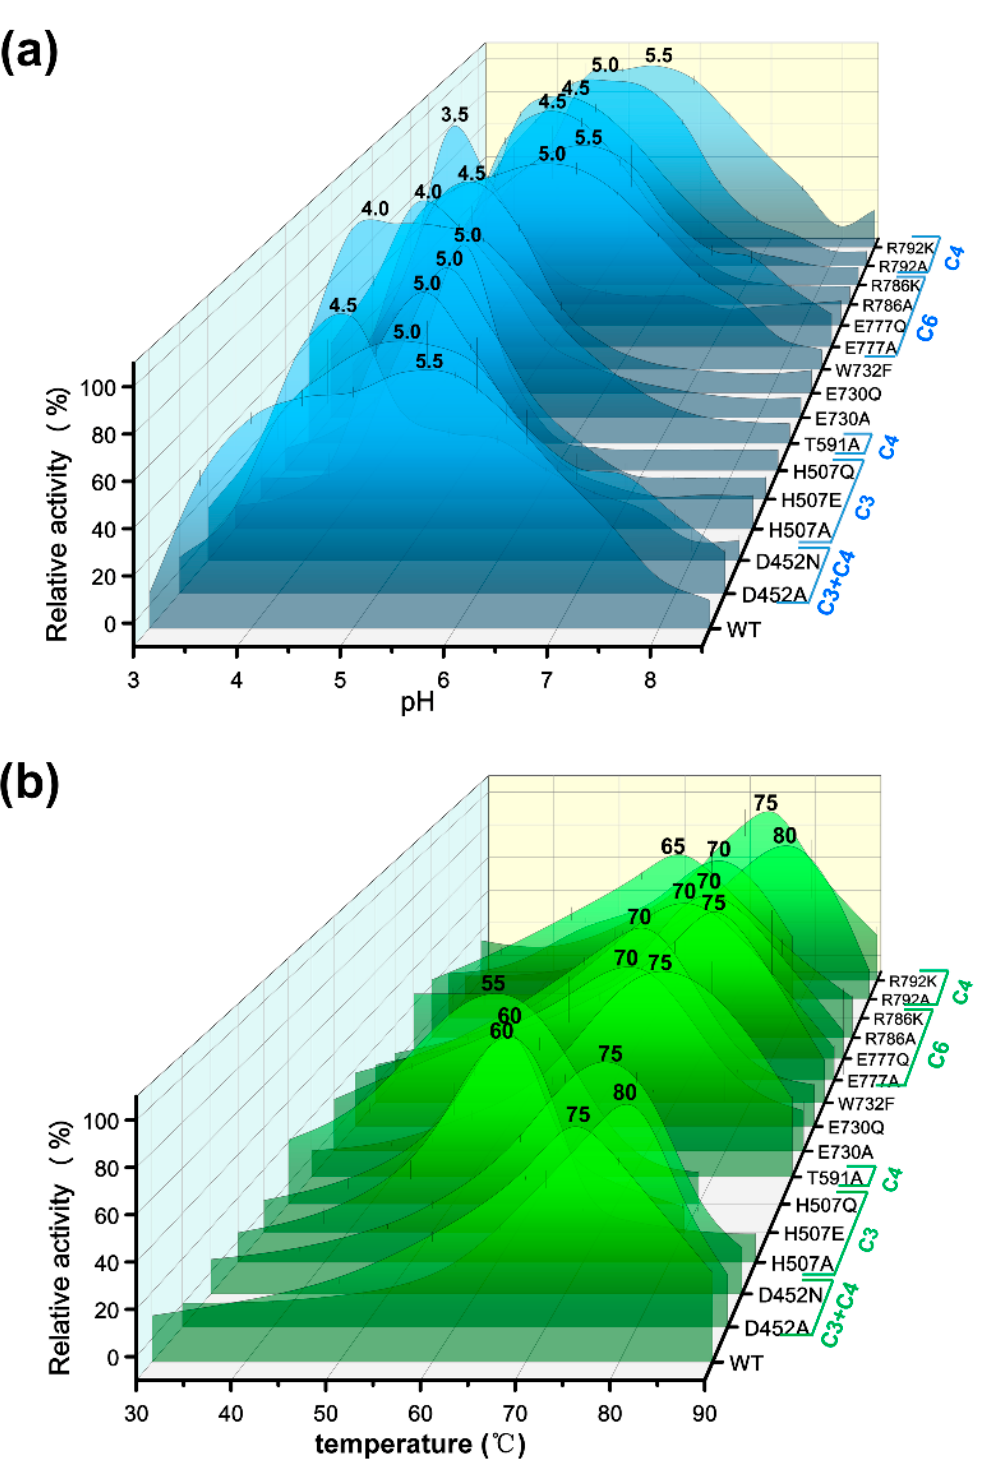
Figure 2. Optimal pH ( a ) and temperature ( b ) analysis of mutants and wild type (WT) Tx GH116. All assays were carried out in triplicate. The 3-D stacked graph was made by Origin 8.0 with Bézier curves. C3, C4, C6, and C3 + C4 represent the glucose carbons carrying hydroxyls interacting with the side chains of the amino acid residues that were mutated.